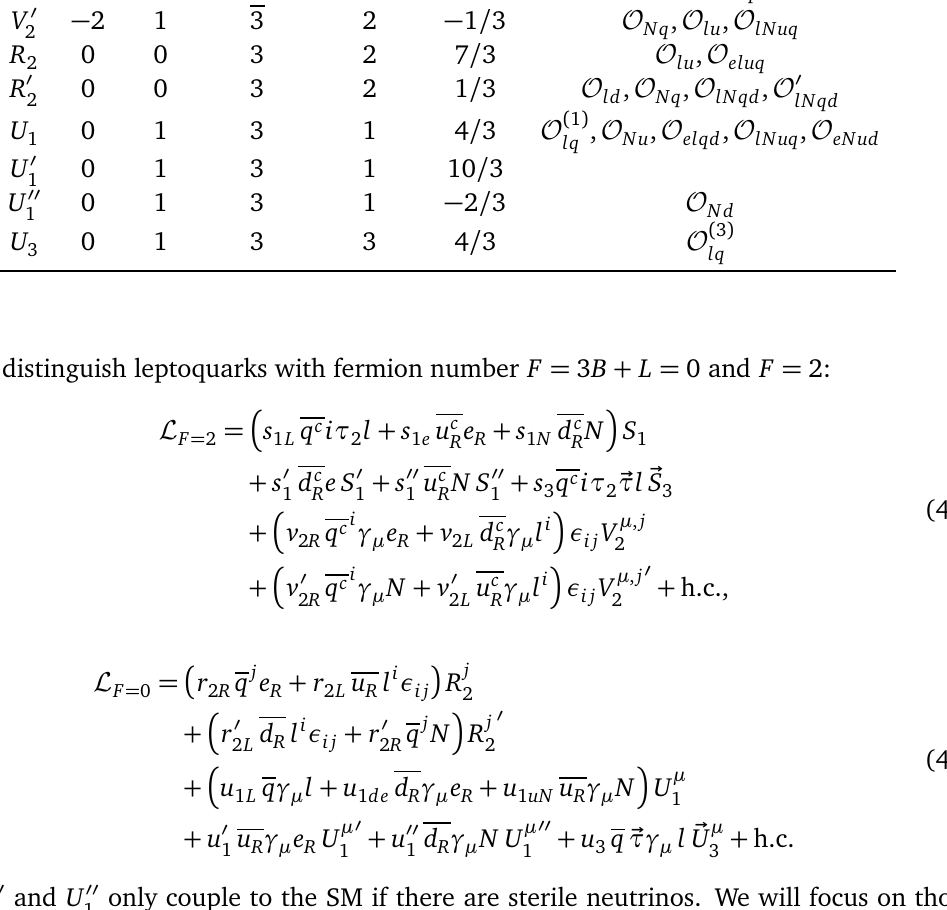
and U (cid:48)(cid:48) , generating only effective 1 1